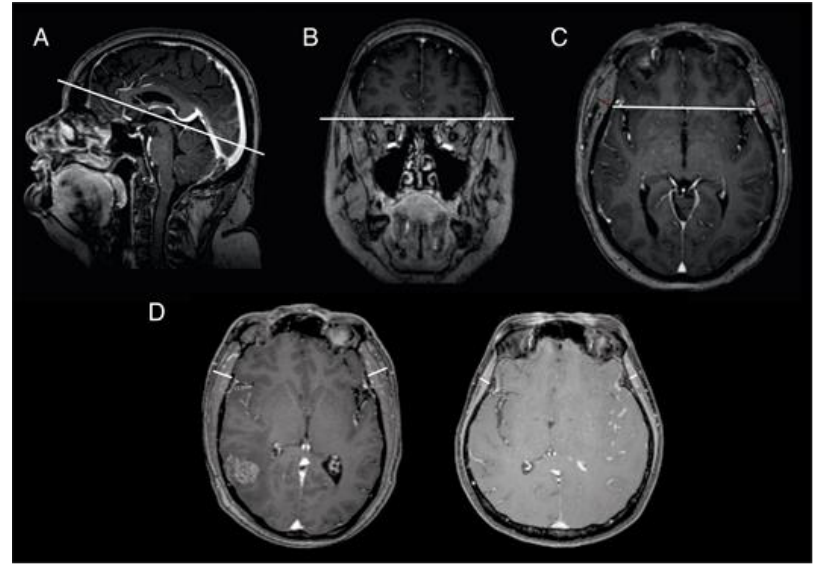
Figure 1. Example of TMT measurements using standard isotropic contrast-enhanced T1-weighted cranial MRI ( A – C ) demonstrate the MRI alignment for TMT acquisition. ( D ) A 57-year-old male without sarcopenia (left), a 48-year-old female with sarcopenia (right). MRI, magnetic resonance imaging; TMT, temporal muscle